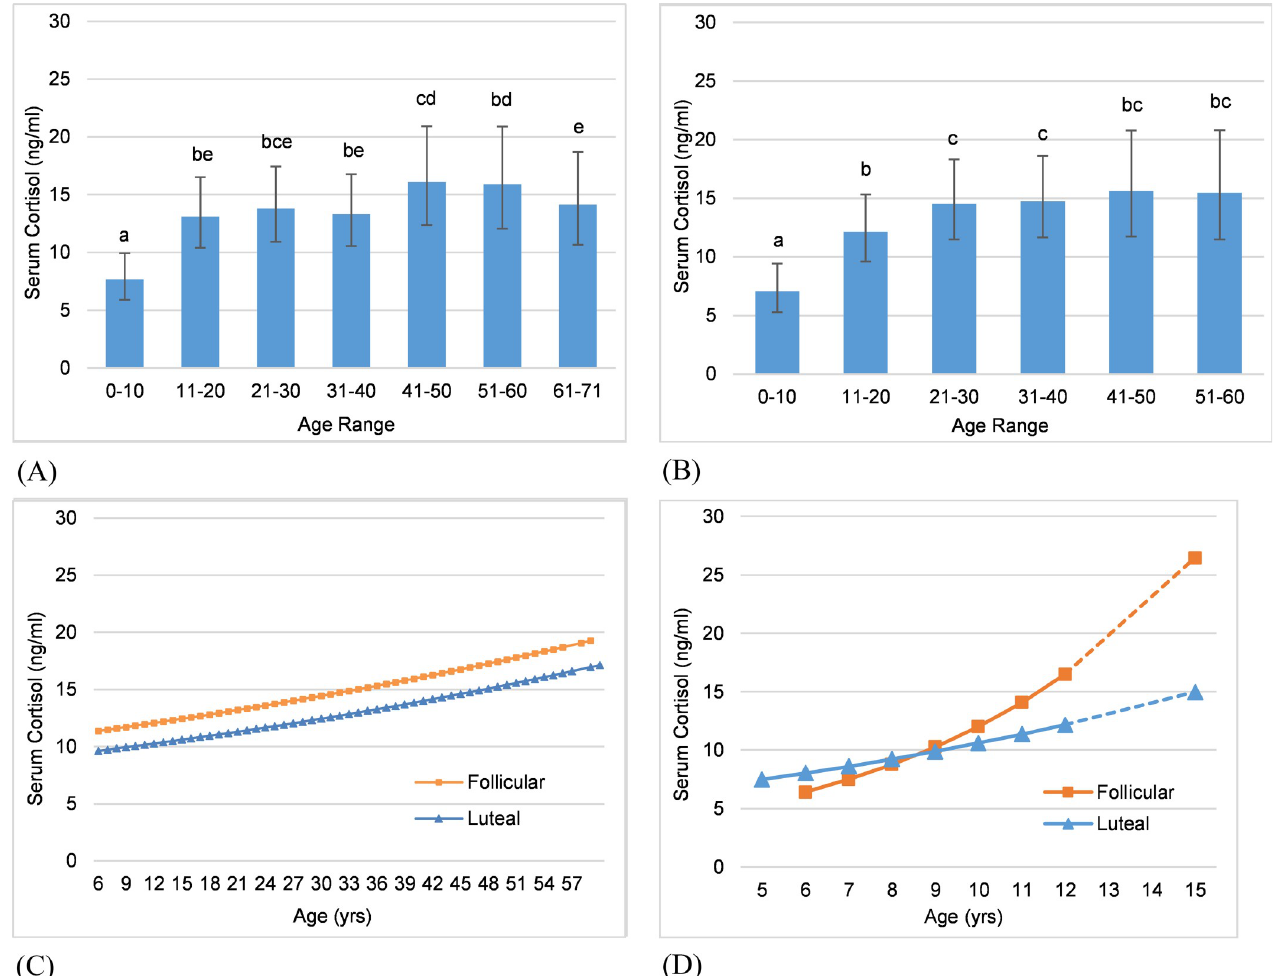
Fig 3. Age as a predictor of adrenal GC activity. Predictions from GLMMs for serum cortisol concentration comparing mean values across age categories (error bars represent standard error of the prediction), and interactions of age and cycle phase. Letters denote significant differences in mean values. Dashed lines in interactions indicate a reproductive state other than normal cycling. (A) All elephants: Comparing mean values across age bins and including all reproductive states. (B) All elephants: Comparing mean values across age bins and including only periods of normal cycling. (C) All elephants: Interaction of age and cycle phase showing the relationship of cortisol and cycle phase with age. (D) F1OZ: Interaction of age and cycle phase showing the relationship of cortisol and cycle phase with age.